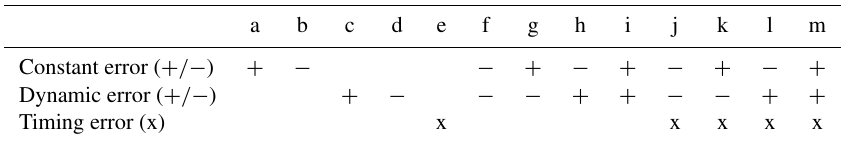
Figure 2. Flow duration curves (FDCs) of observed (blue) and manipulated (dashed red) streamflow time series. Manipulated FDCs are depicted for (a, b) constant errors only, (c, d) dynamic errors only, (e) timing error only, and (f–i) combination of dynamic and constant errors. The combination of constant errors, dynamic errors, and timing error is not shown, since their FDCs are identical to (f) – (i) . Y axis is shown in log space. Table 1. Summary of error types and their combinations as described in Sect. 3.1 (a–m). + ( − ) reflects a positive (negative) error type. For timing error, only one error type exists